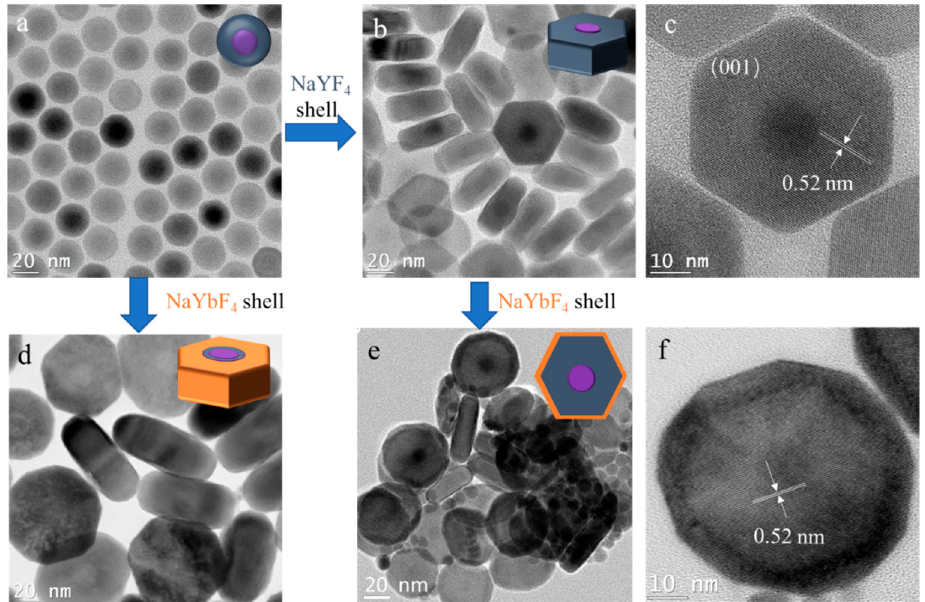
Figure 5. TEM images of NaGdF 4 /NaYF 4 spherical nanocrystals as core ( a ) for transversal growth with different host shells: NaYF 4 shell ( b ) and NaYbF 4 shell ( d ). NaGdF 4 @NaYF 4 nano-disk ( b ) as core for another transversal shell growth with a layer of NaYbF 4 shell ( e ). High-resolution TEM images of NaGdF 4 /NaYF 4 nano-disks ( c ) and NaGdF 4 /NaYF 4 /NaYbF 4 nano-disks ( f